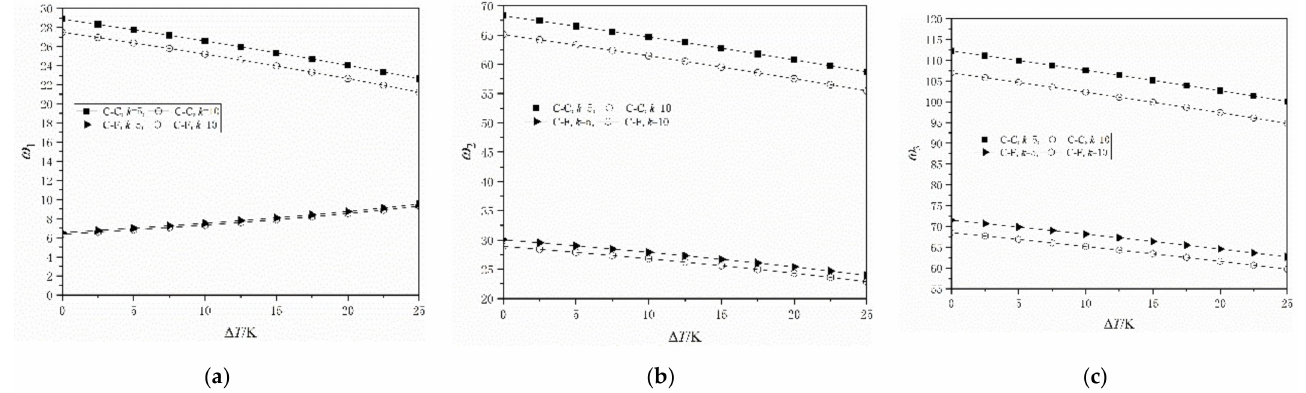
Figure 10. The relationship between dimensionless natural frequencies and the temperature change under two different boundary conditions (Reddy plate). ( a ) The first-order frequencies; ( b ) The second-order frequencies; ( c ) The third-order